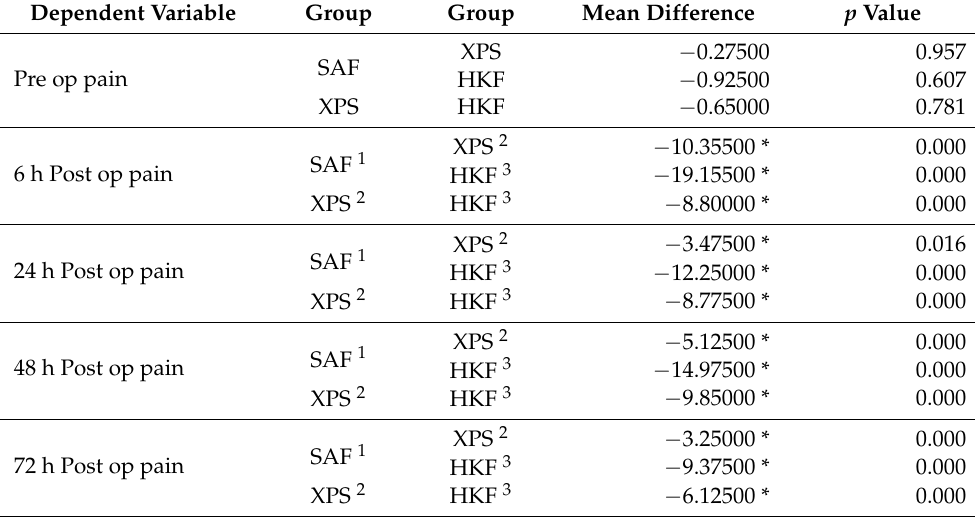
Table 4. Multiple pairwise comparisons using Tukey